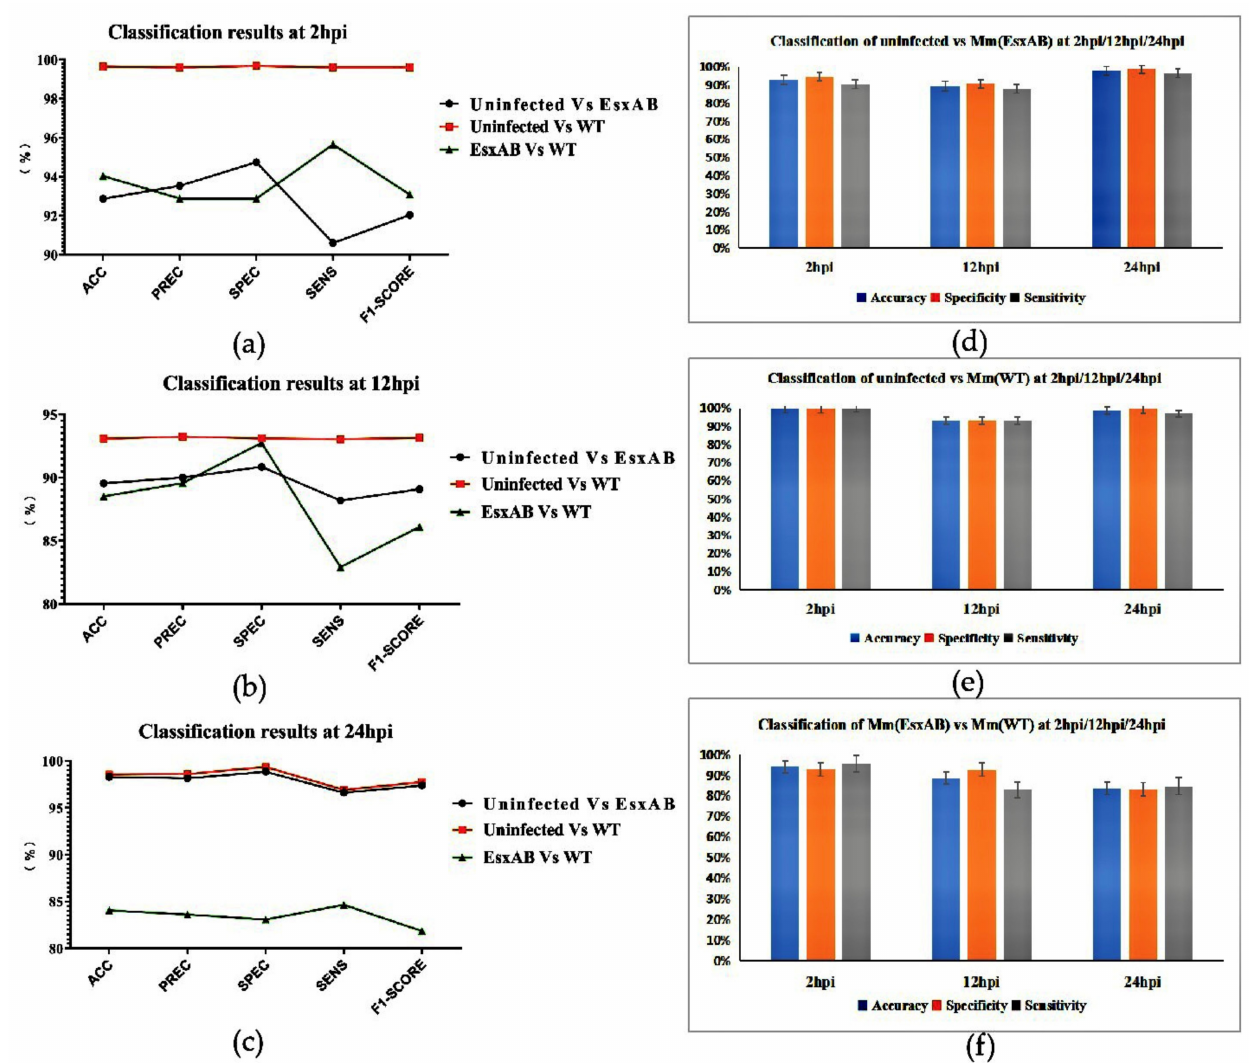
Figure 6. Infection analysis results of THP-1 cell dataset through the AutoCellANLS (The cell classification results were evaluated by accuracy, precision, specificity, sensitivity and F1-Score. ( a – c ) show the results for different cell groups (uninfected vs. Mm( ∆ EsxAB), uninfected vs. Mm(WT), and Mm( ∆ EsxAB) vs. Mm(WT)) at the same time periods, respectively. In addition, we also compared the classification results ( d – f ) for the same group of cells in different periods (2 hpi/12 hpi/24 hpi) to obtain the morphological changes over time during the process of cell infection. (ACC: accuracy, (TP + TN)/(TP + TN + FP + FN); PREC: Precision, TP/(TP + FP); SPEC: Specificity, TN/(FP + TN); SENS: Sensitivity (or Recall), TP/(TP + FN); F1-Score: (2 × Precision × Recall)/(Precision +